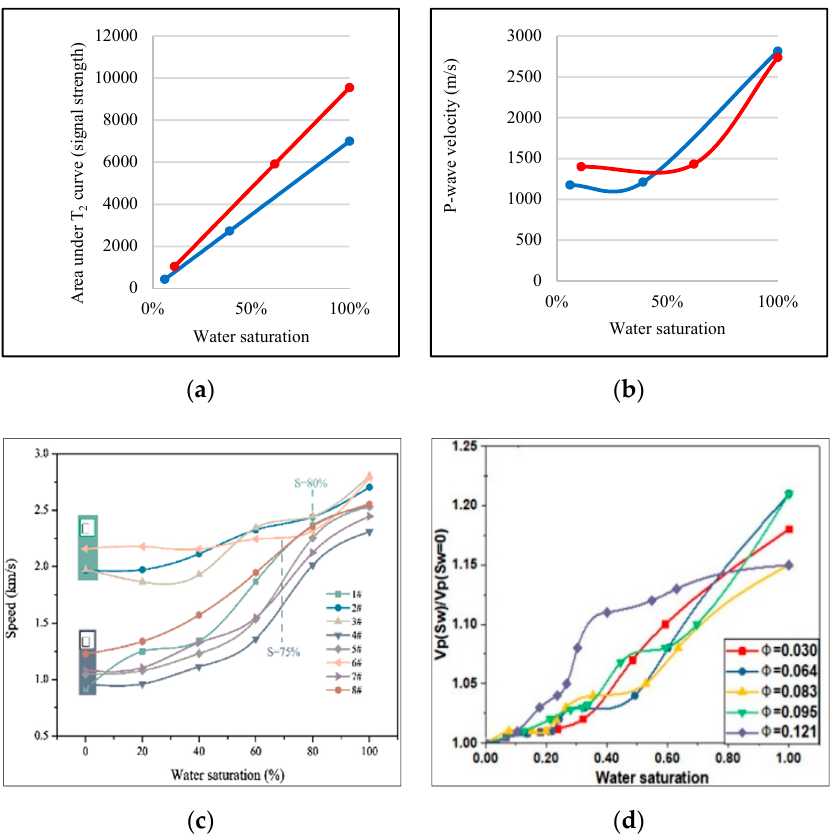
Figure 6. The relationship between water saturation and area under T 2 curve ( a ), and P-wave velocity ( b ). Our results were compared with the existing literature: ( c ) after [33] and ( d ) after [43].